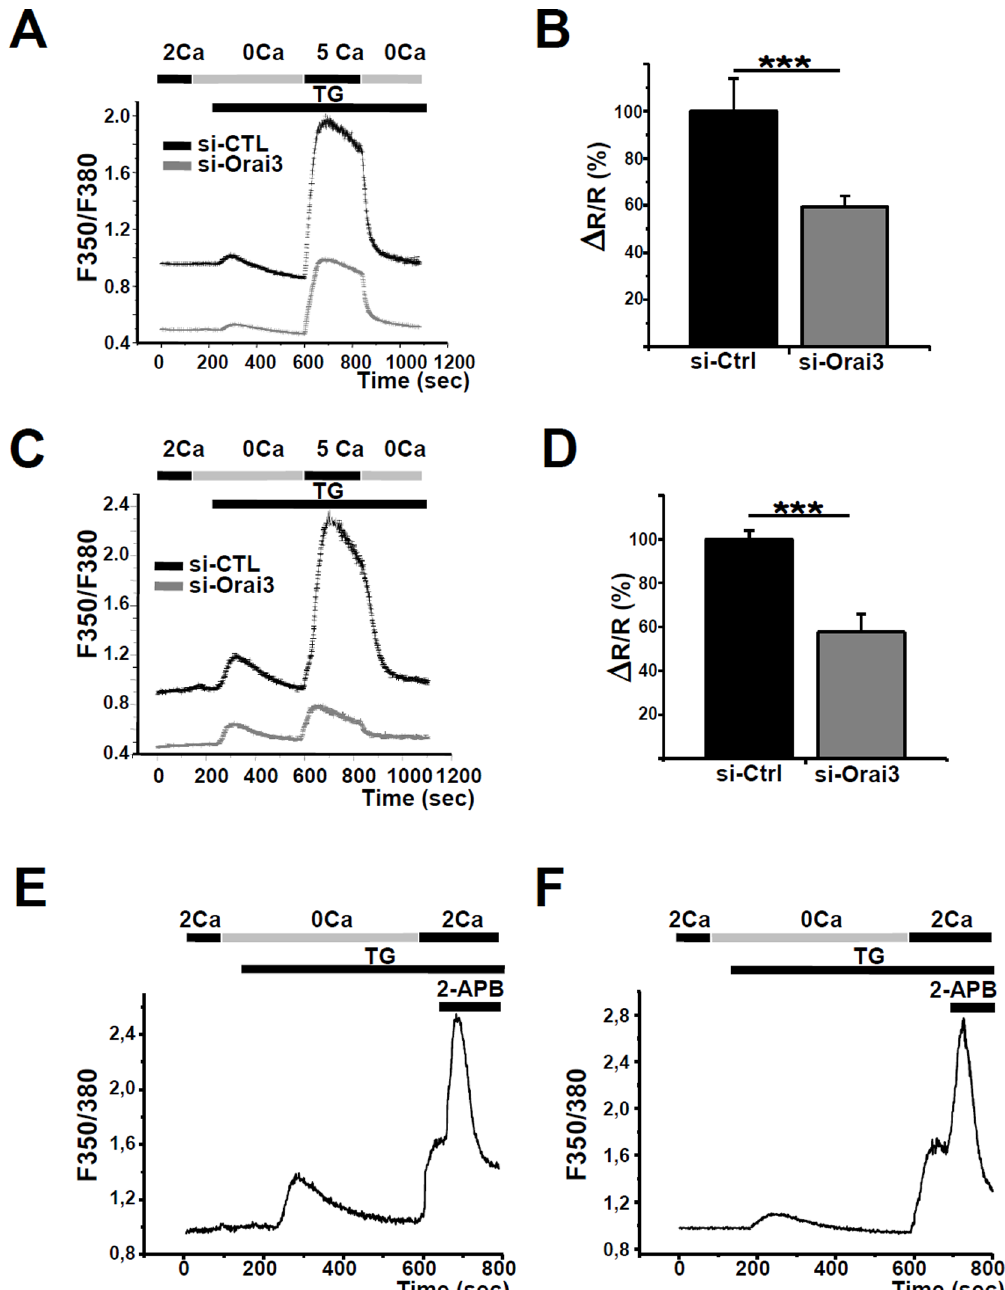
Figure 4. Effect of Orai3 knockdown on SOC entry. The effect of siRNA against Orai3 on thapsigargin-activated SOCE in (A) NCI-H23 cells (n=25 cells for each condition) and (C) NCI-H460 cells (n=27 cells for each condition). Down-regulation of Orai3 expression produced a significant reduction of basal calcium concentration. [Ca 2 + ] i is measured after 1 minute of standard solution extracellular perfusion. B–D) Quantitative analysis of SOCE in NCI-H23 cells (B, n=25) and NCI-H460 cells (D, n=27). The values presented as mean 6 SEM. (*** p , 0.001, Mann-Withney test). Perfusion of 50 m M 2- APB transiently potentiates SOCE in NCI-H23 (E, n=45) and NCI-H460 cells (F, n=54). The values presented as mean 6 SEM. (*** p , 0.001, Mann- Withney